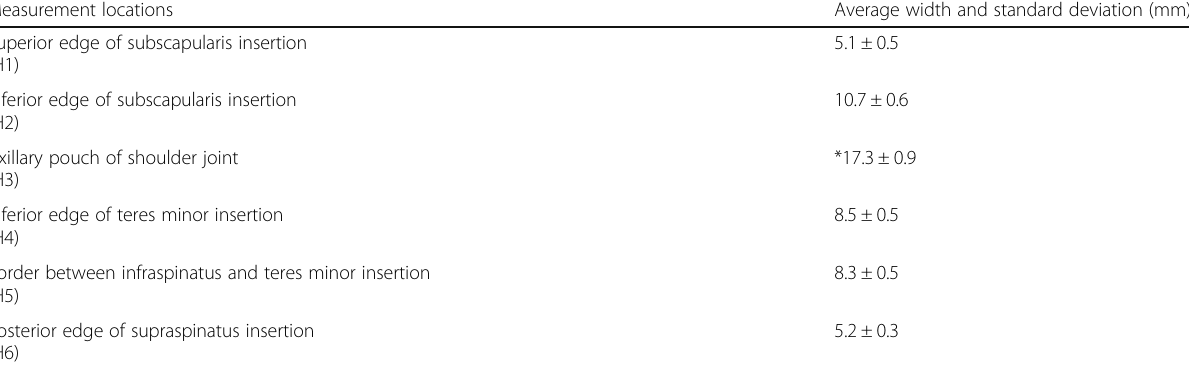
Table 2 Measurements of the humeral attachment of the articular capsule Measurement locations